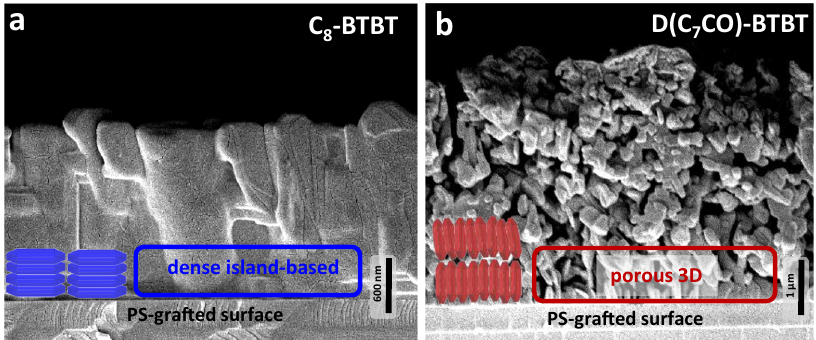
Fig. 5 SEM characterization of C 8 -BTBT vs . D(C 7 CO)-BTBT fi lms on PS-grafted surfaces. Cross-sectional SEM images of the nanostructured fi lms of C 8 -BTBT ( a ) and D(C 7 CO)-BTBT ( b ) on hydrophobic PS-grafted surfaces. The corresponding dense island-based (in blue) and porous 3D (in red) morphologies, and the relative directions of “ face-on ” (in blue) and “ edge-on ” (in red) oriented BFDH (Bravais, Friedel, Donnay, and Harker) theoretical crystal morphologies were shown for the initial stages of the organic fi lm growths. Scale bars are shown separately for each SEM